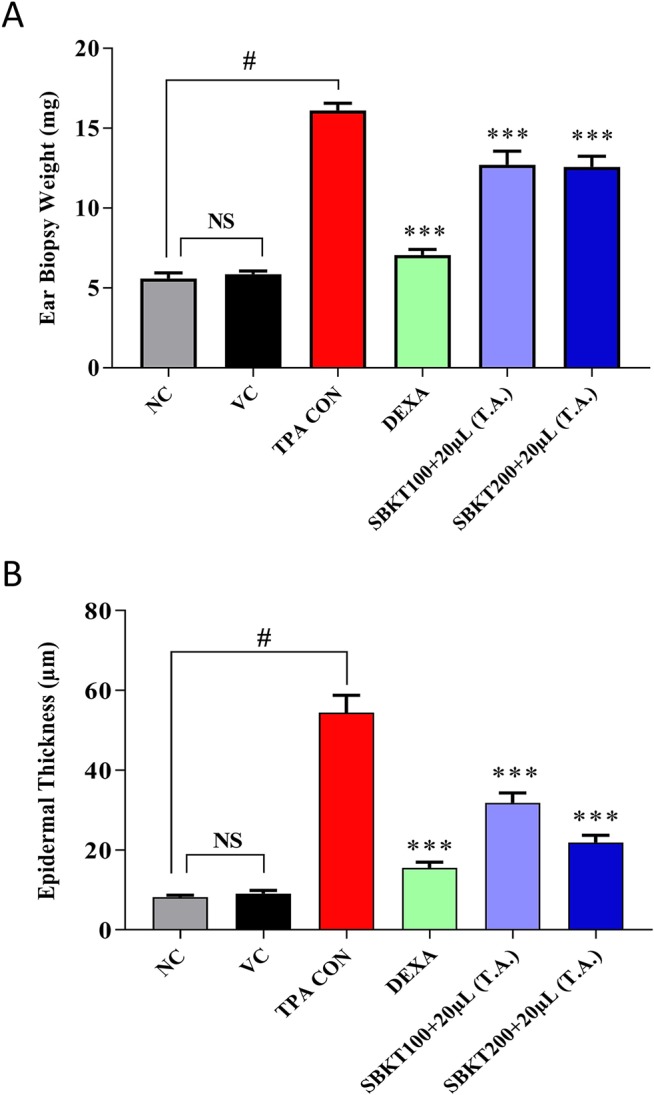
Effect of SBKT on TPA-induced ear biopsy weight in mice. Co-treatment of the psoriatic ear with SBKT (100 and 200 mg/kg; p.o. and 20 μl T.A.) or with DEXA (0.2 mg/ear; T.A.) significantly reduced the (A) ear biopsy weight and (B) ear epidermal thickness. Statistical analysis was performed using one-way ANOVA method followed by Dunnett’s multiple comparison t test (n = 8 animals). #p < 0.001 (NC versus TPA CON); NS p>0.05 (NC versus VC); ***p < 0.001 (TPA CON versus SBKT; TPA CON versus DEXA). NC, normal control; VC, vehicle control; TPA CON, 12-O-tetradecanoyl phorbol-13-acetate; DEXA, dexamethasone; SBKT, sea buckthorn oil.